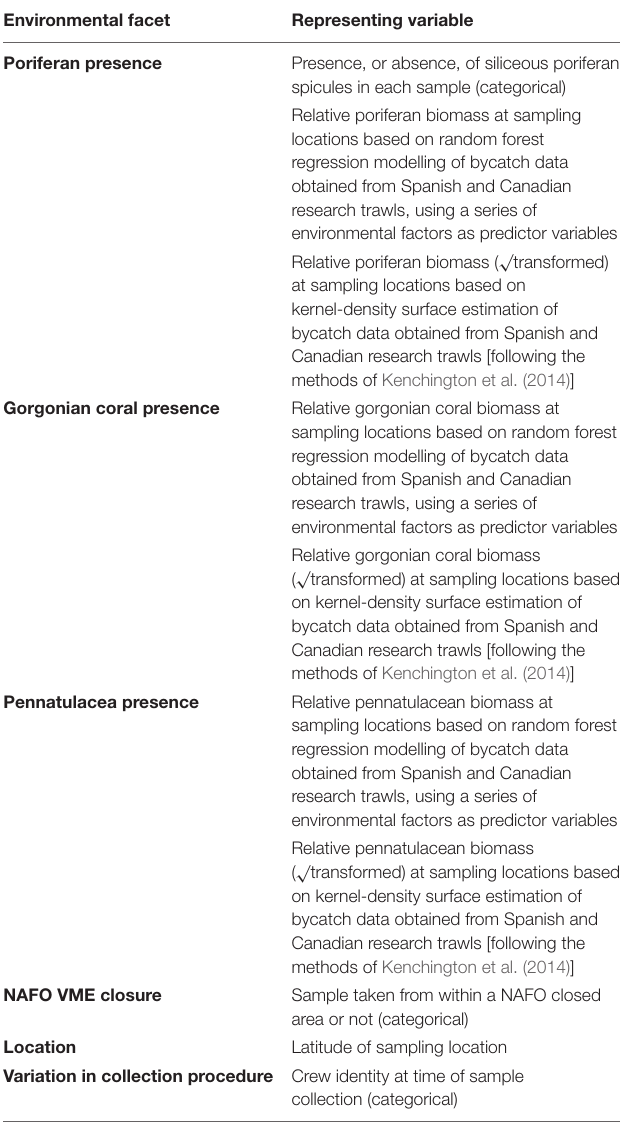
TABLE 2 | Details of the environmental variables retained for analysis following Variance Inflation Factor variable selection. Environmental facet Representing